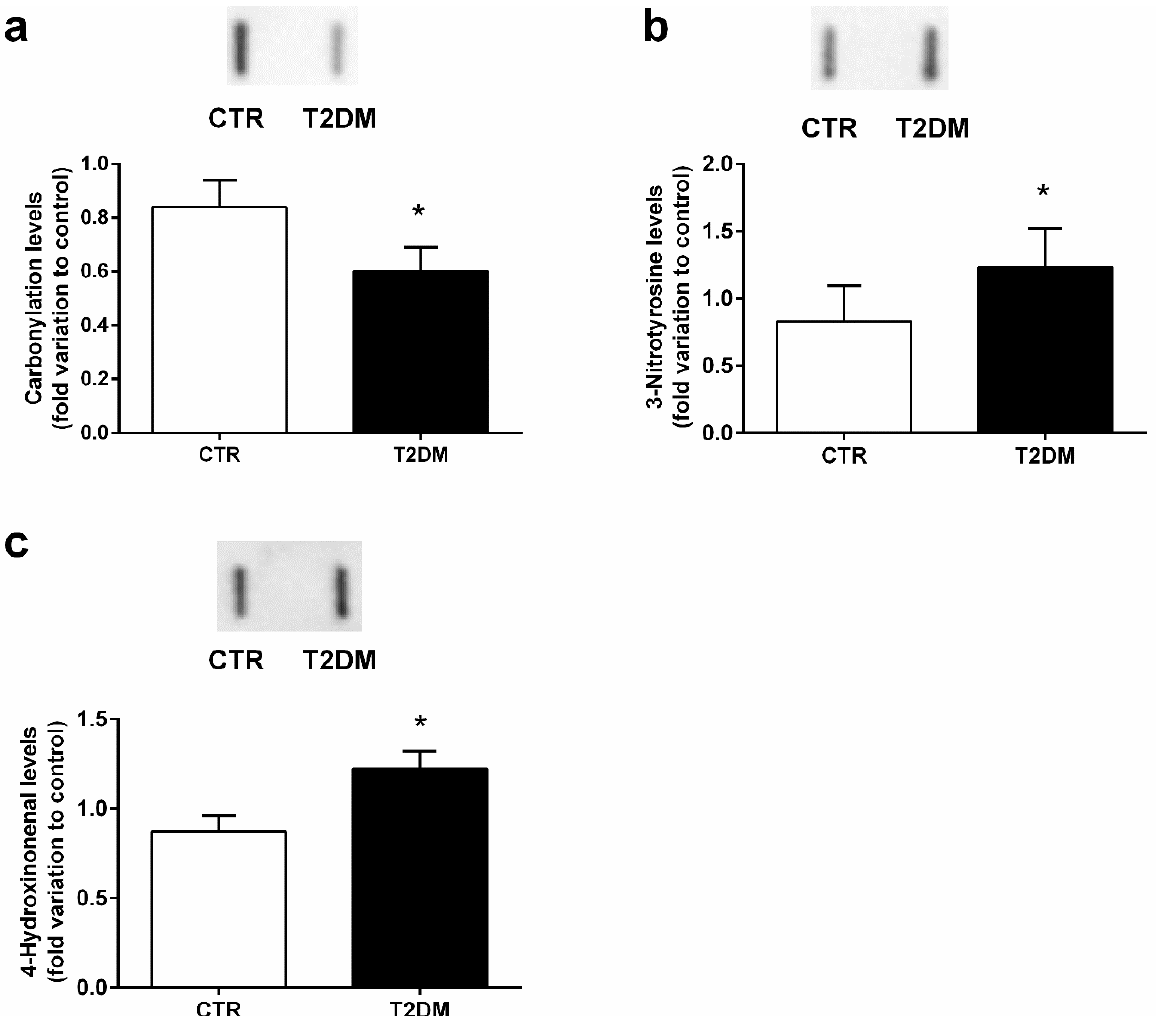
Figure 5. Epididymal antioxidant parameters in the control group and the T2DM group. ( a ) protein carbonylation; ( b ) protein nitration; ( c ) lipid peroxidation. Number of animals per group: 7 in the control group and 7 in the T2DM group. Results are presented as mean ± SEM of three independent experiments. Significantly different results ( p < 0.05) are indicated: * relative to control. The insets of panel a, b, and c represents an illustrative Slot Blot experiment for the control and type 2 diabetic animals (T2DM).